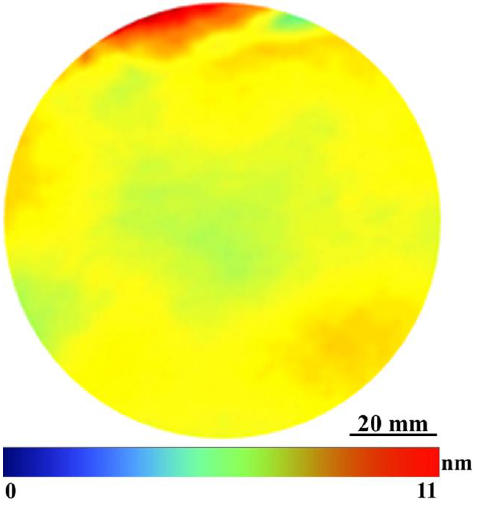
Figure 11. The error map of the surface shape.